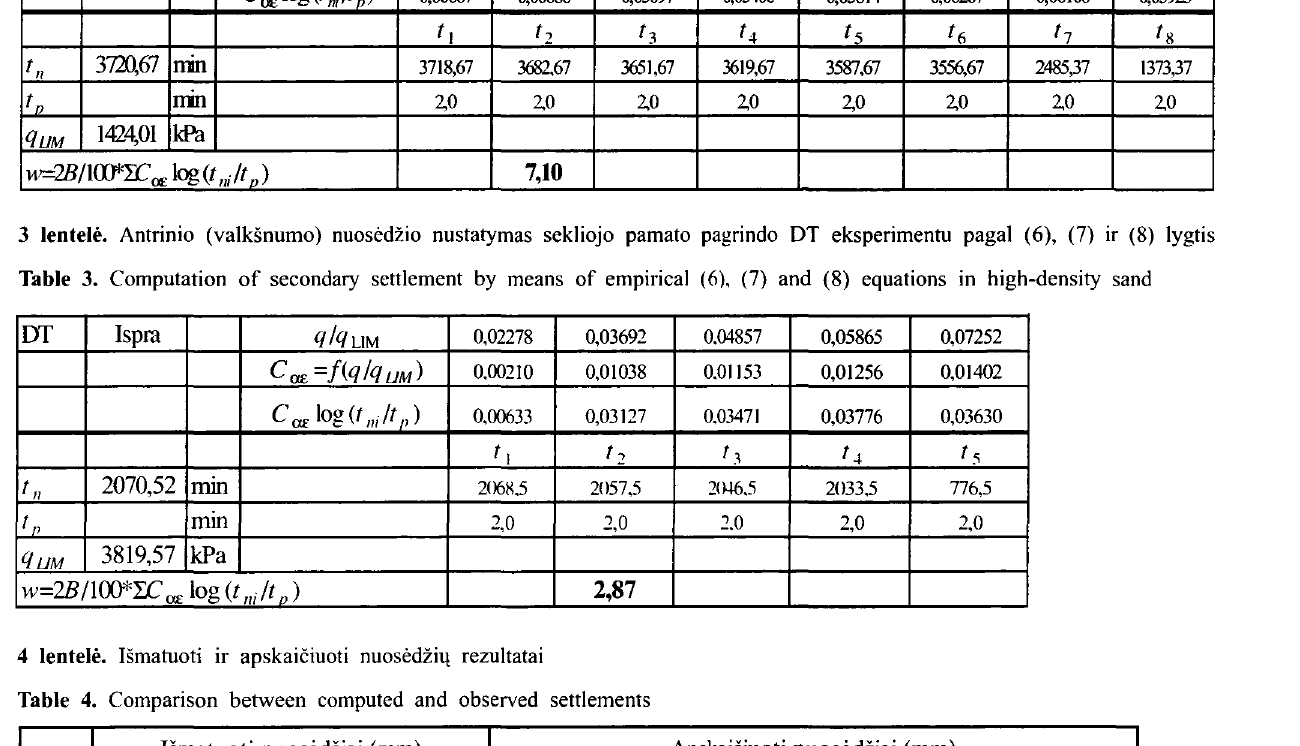
Table 4. Comparison between computed and observed settlements ISmatuoti nuosedziai (mm) ApskaiCiuoti nuosedziai (mm) Akimirksninis Antrinis Suminiai